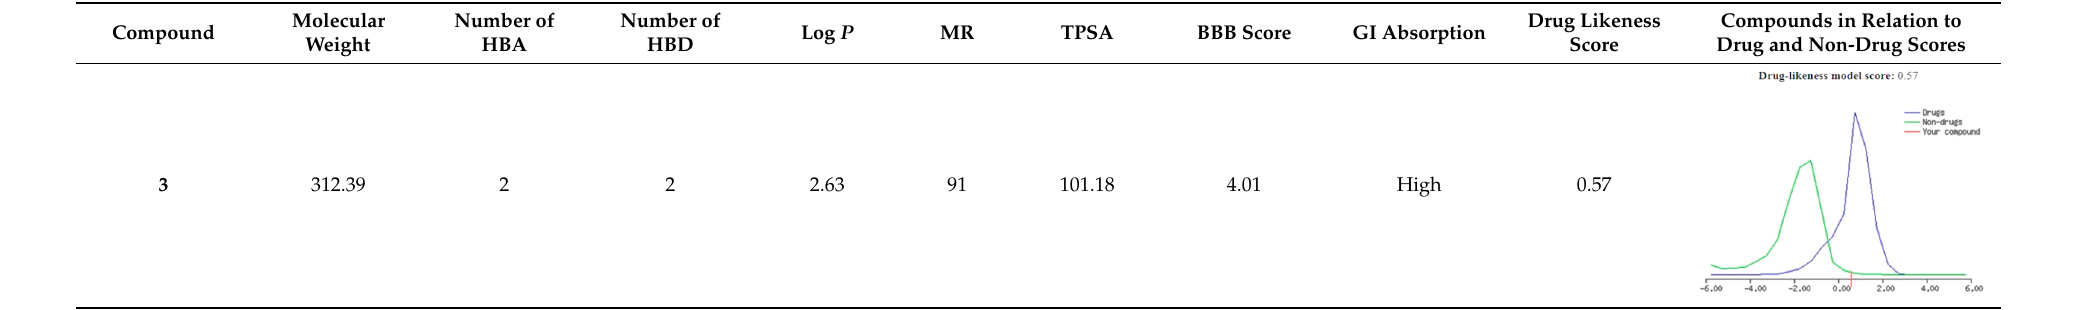
Figure 5. Oral bioavailability represented in the red zone for the compound under investigation. Table 3. Pharmacokinetics data and drug likeness value for the tested Table 3. Pharmacokinetics data and drug likeness value for the tested compound.